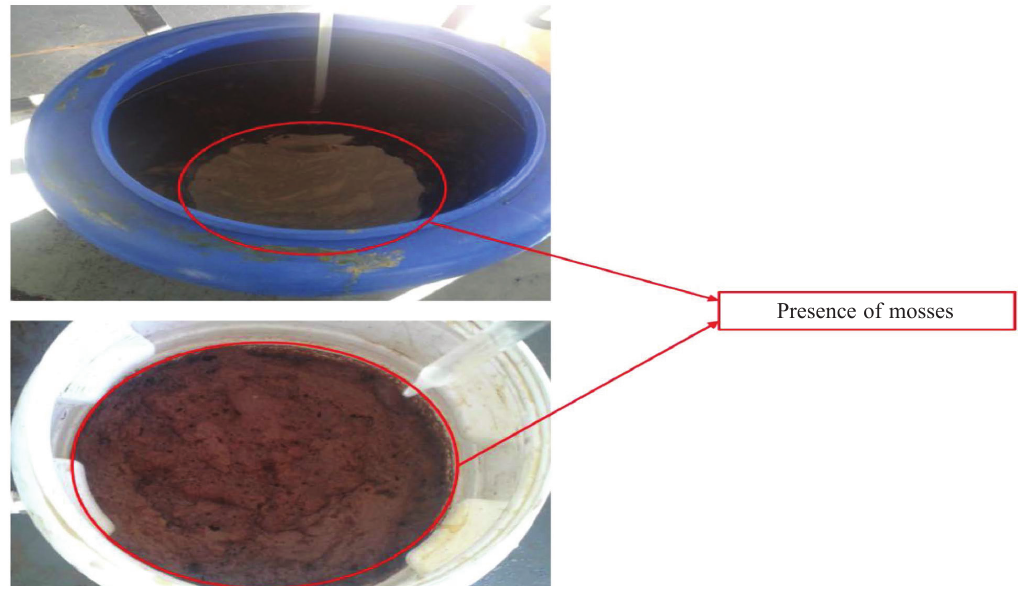
Fig. 1 – Foam generated by the detergents at the WWTPs of the city of Kenitra